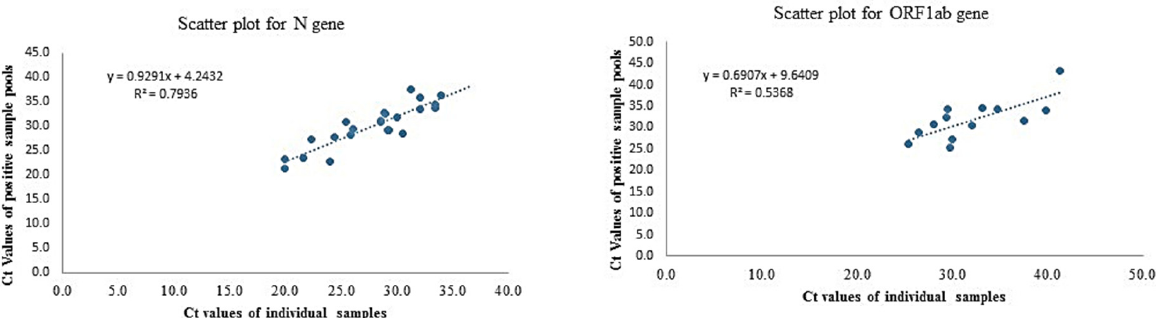
Figure 6. The Ct values comparison of N and ORF1ab gene with individual testing vs. pool testing.